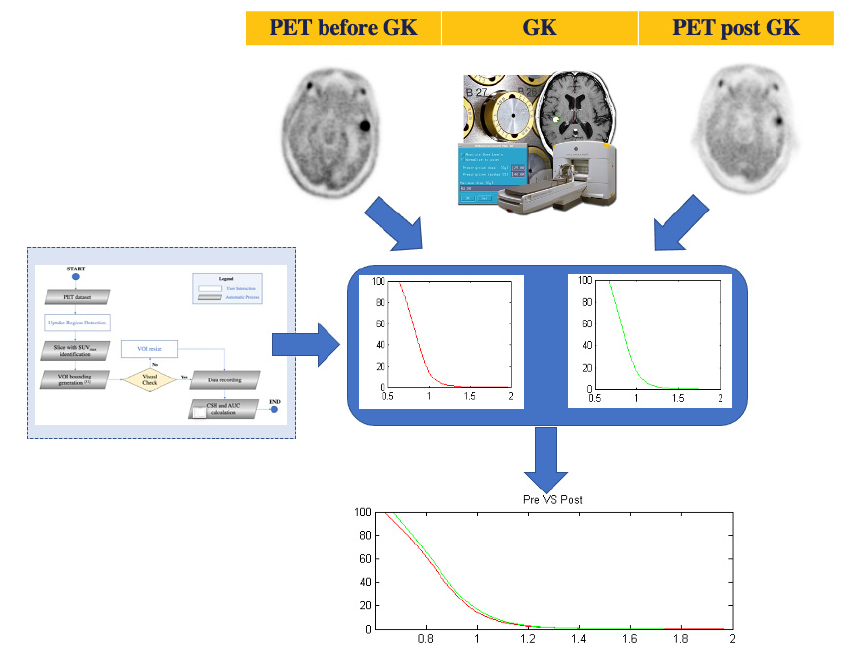
Figure 3. The workflow of the proposed study.